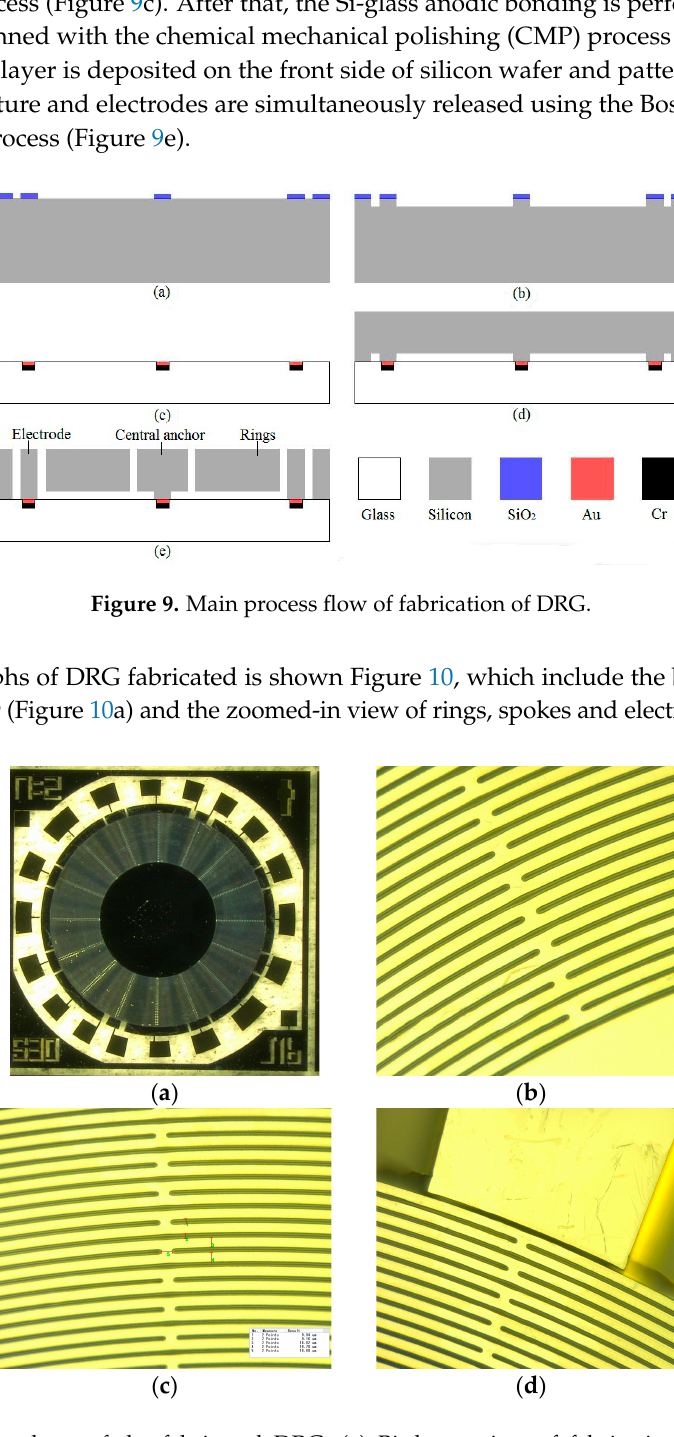
Figure 10. The photo of the fabricated DRG. ( a ) Bird eye view of fabrication disk resonator; ( b ) Zoomed-in the view of rings, spokes and disk; ( c ) Zoomed-in view of rings and spokes; ( d ) Zoomed-in the view of electrodes